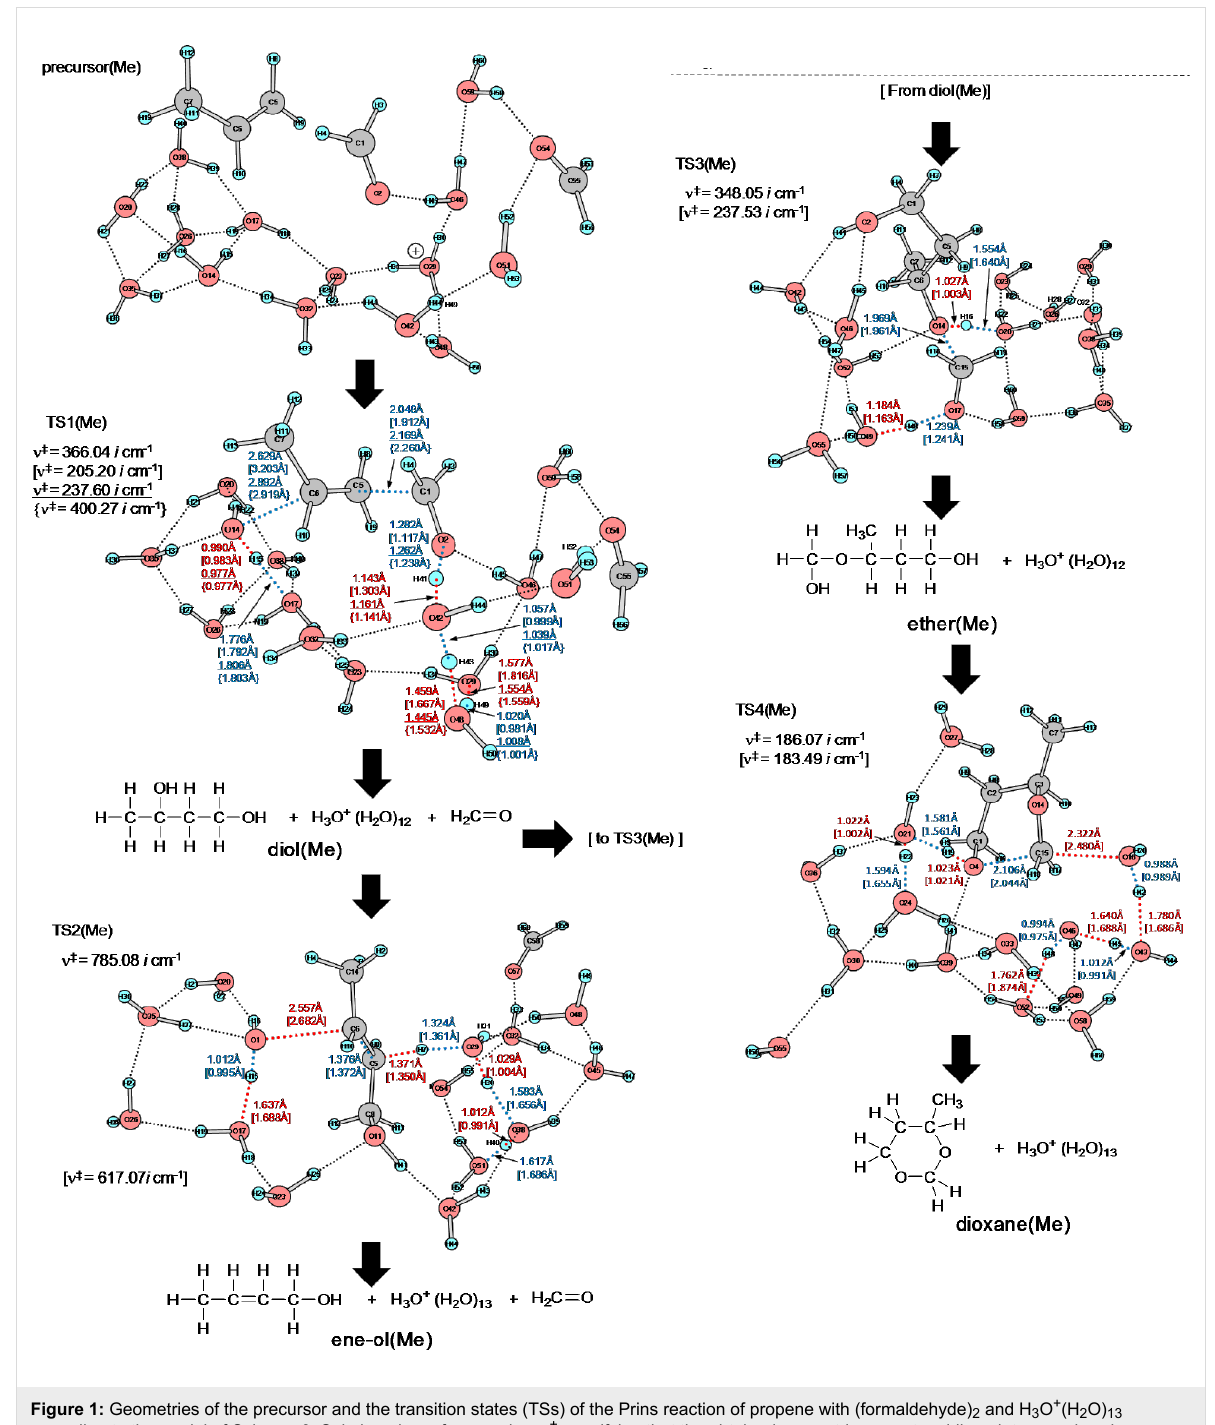
Figure 1: Geometries of the precursor and the transition states (TSs) of the Prins reaction of propene with (formaldehyde) 2 and H 3 O + (H 2 O) 13 according to the model of Scheme 6. Sole imaginary frequencies, ν ‡ s, verifying that the obtained geometries are at saddle points, are also shown. Those of intermediates and products are exhibited in Figure S1 of Supporting Information File 1. "(Me)" denotes the propene (R–HC=CH 2 , R = Me) reaction. Distances and imaginary frequencies by B3LYP/6-31G(d) and B3LYP/6-311+G(d,p) (in square brackets) are shown. Underlined numbers are by M06-2X and those in braces by ω B97XD for TS1(Me).